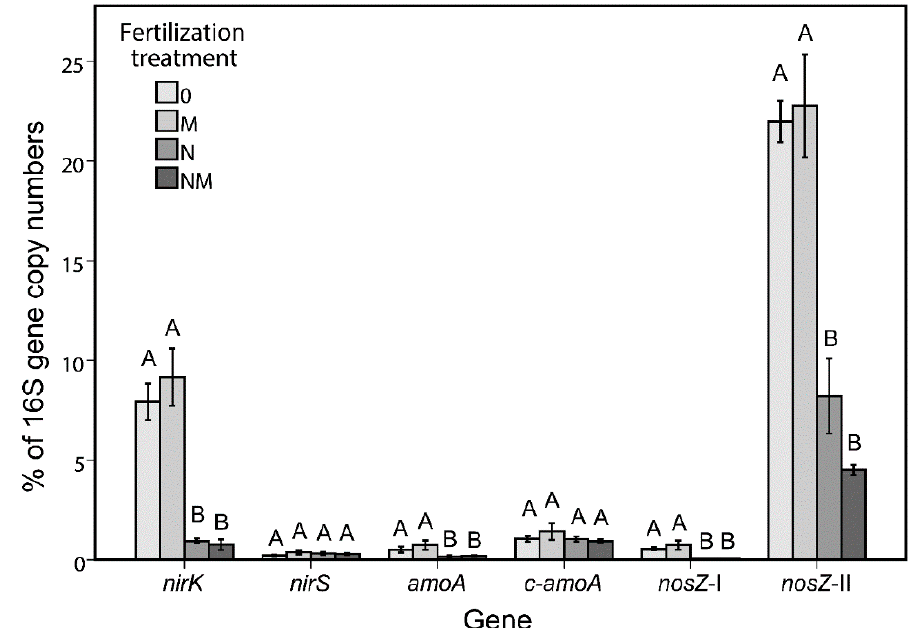
Figure 3. Relative abundance (% of 16S rRNA gene copy number) of nitrogen cycle-related genes (bacterial amoA , archaeal amoA , nirK , nirS nosZ -I and nosZ -II) in the bulk soil under the four N-fertilization treatments. Different letters above the bars indicate significantly different means (Tukey HSD, p < 0.05) among each gene. Treatments: 0, no N-amendment; N, mineral-N amendment; M, manure amendment; NM, mineral-N + manure amendment.